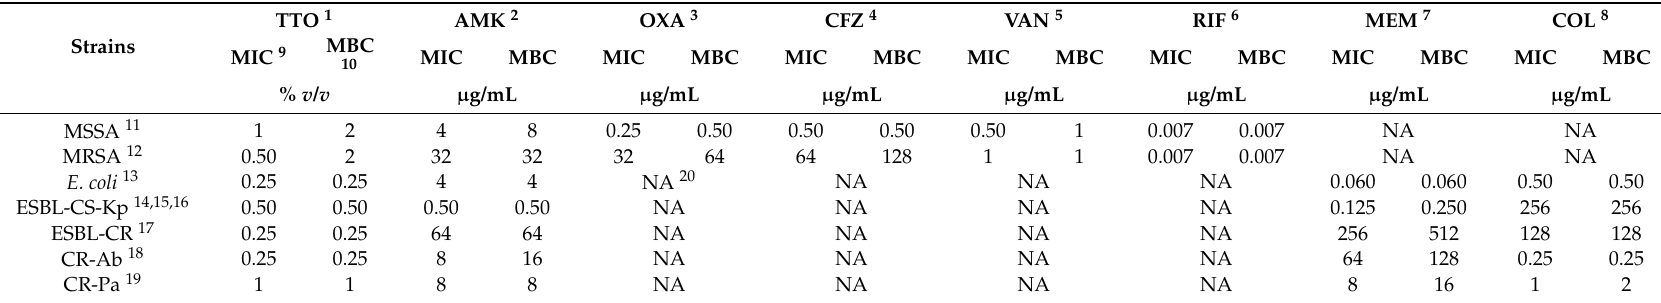
Table 2. Antibacterial activity of TTO and different antimicrobials against MSSA, MRSA, Escherichia coli , ESBL-CS-Kp, ESBL-CR-Kp, CR-Ab, and CR-Pa. TTO 1 Strains